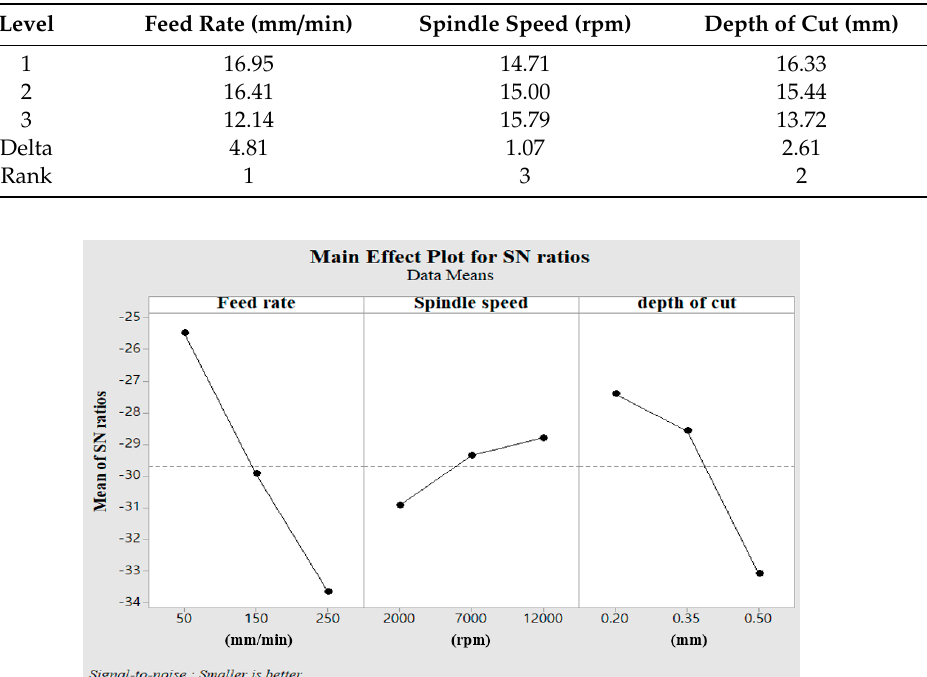
Table 6. Response table mean S / N ratio for the surface roughness, according to the machining conditions.